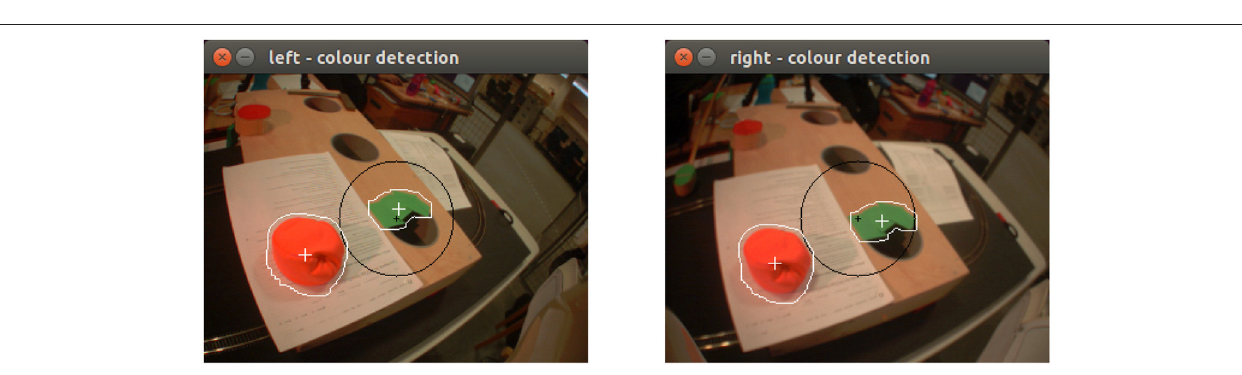
red and green targets are updated to constitute a fresh world state for Dev-PSchema’s postcondition matching and excitation